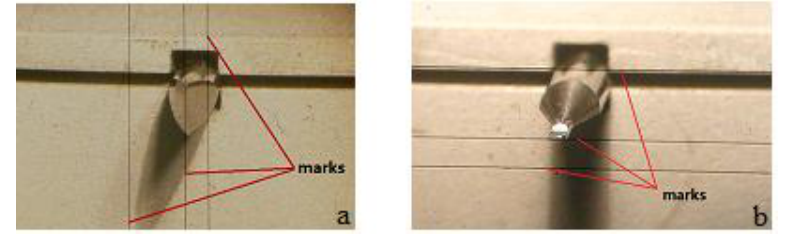
Figure 4. Adjusting microscope under microscope. ( a ) A triangle microscriber adjustment process under a microscope; ( b ) A rectangle microscriber adjustment process under a microscope.